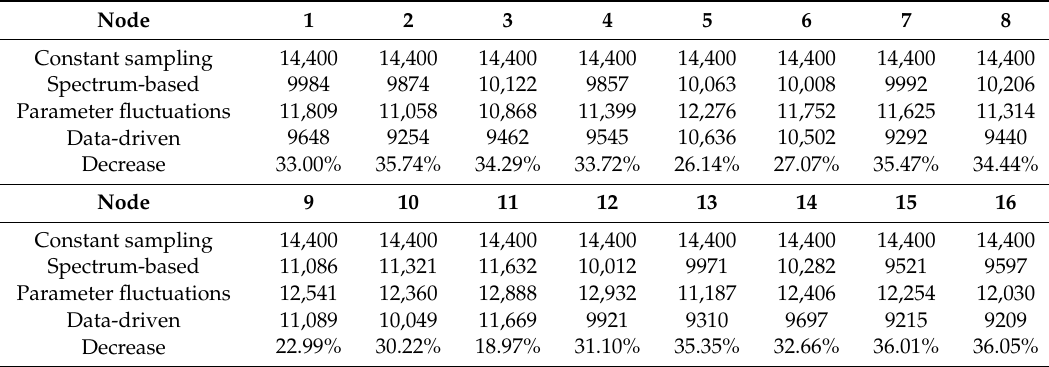
Table 4. Comparison of data collected by various